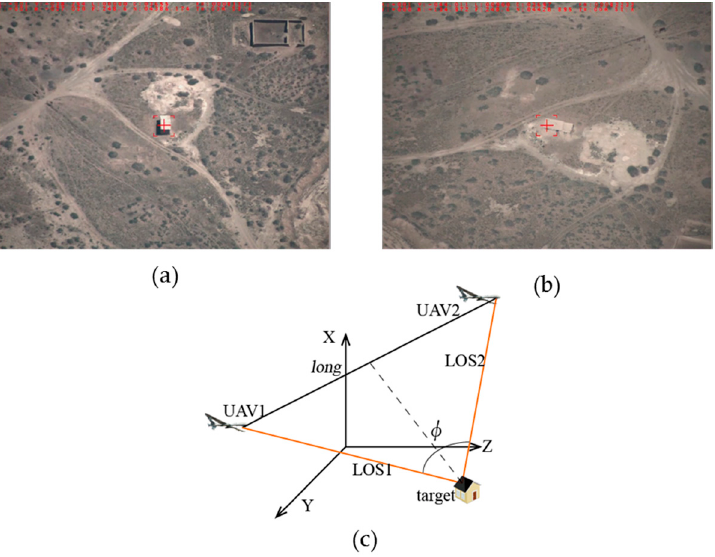
Figure 14. Feature position 2: ( a ) target detection by UAV1; ( b ) target detection by UAV2; and ( c ) positional relationship graph between the two UAVs and the target.